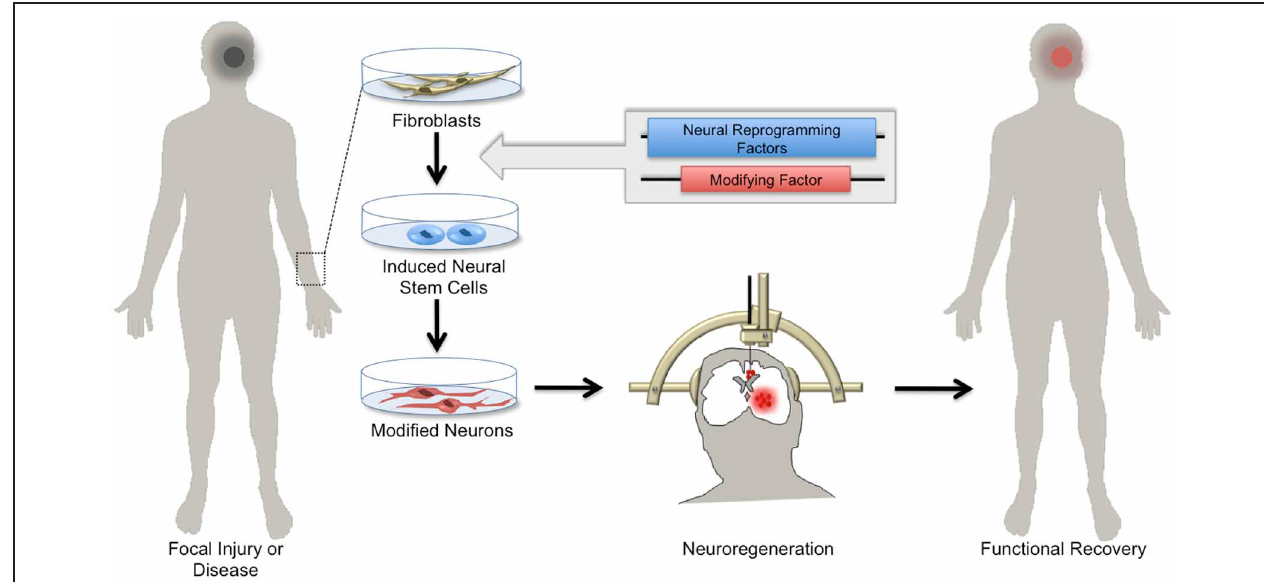
FIGURE 4 | Hopes for using induced neuronal stem cells for regenerative medicine. Skin biopsies from patients with focal neurological injury or neurodegenerative disease are a ready source of fibroblasts. Using the approach of cellular reprogramming and subsequent genetic manipulations, patient-derived fibroblasts can be differentiated into induced neural stem cells (iNSCs) harboring functional